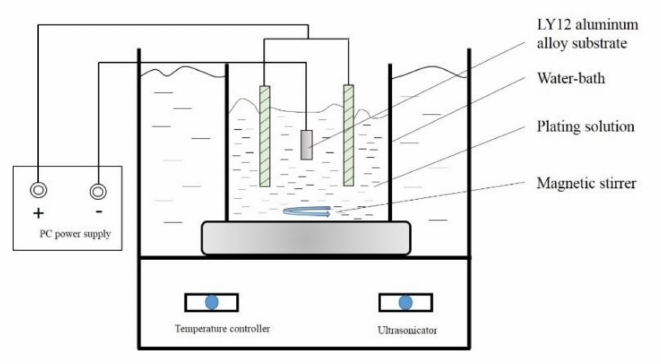
Figure 2. Schematic diagram of pulse electrodeposition battery.